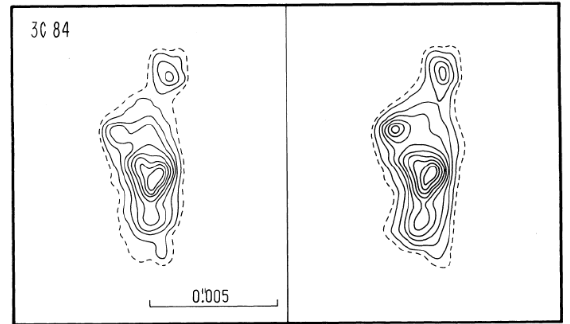
Figure 1. Two maps of 3C84 observed at 6 cm wavelength and taken from [11]. The map on the left shows the source structure in 1973.0 and the map on the right in